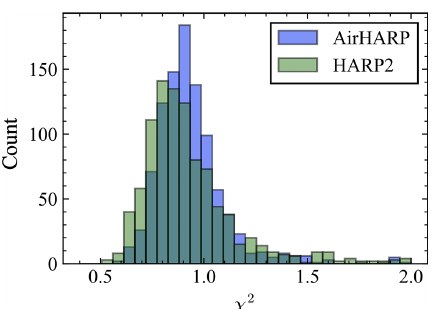
Figure 3. The histogram of the cost function values for the synthetic retrievals.